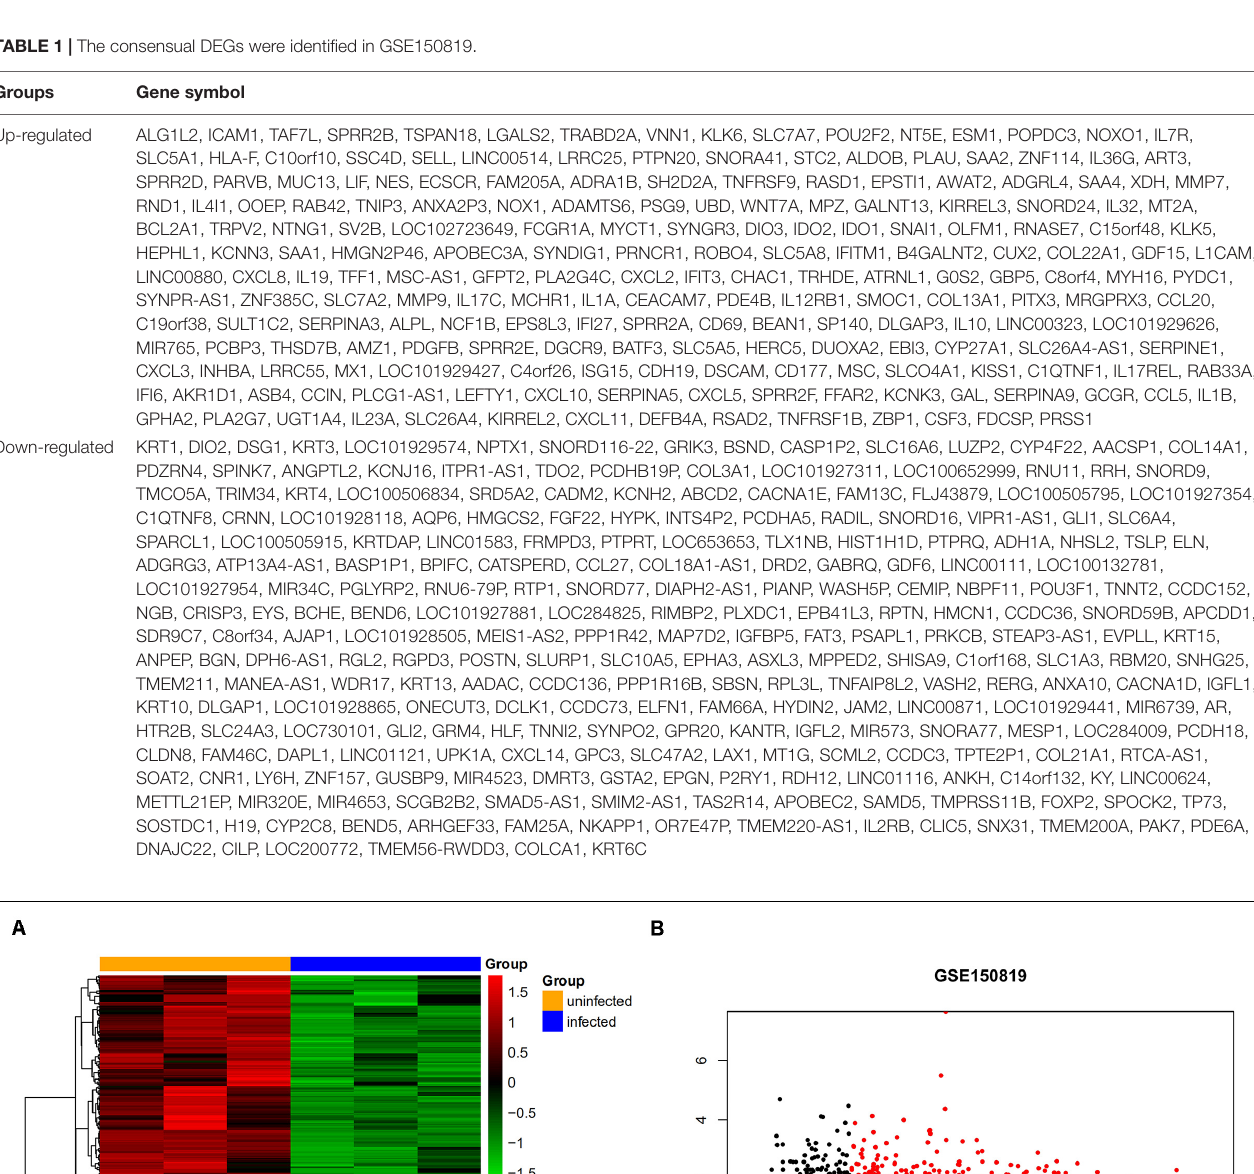
Frontiers in Physiology |